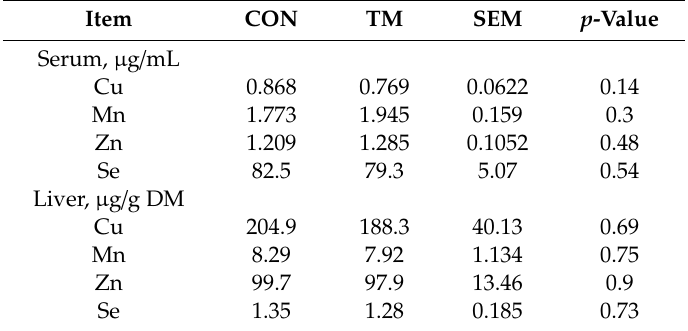
Table 4. E ff ects of maternal supplementation of trace minerals on serum and hepatic trace mineral concentrations of steer progeny during the finishing